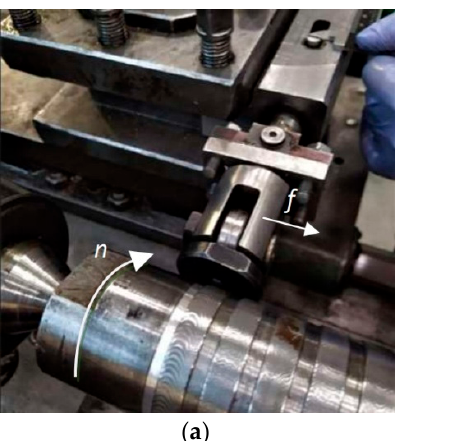
Figure 1. Schematic diagram of the experiment carried out.